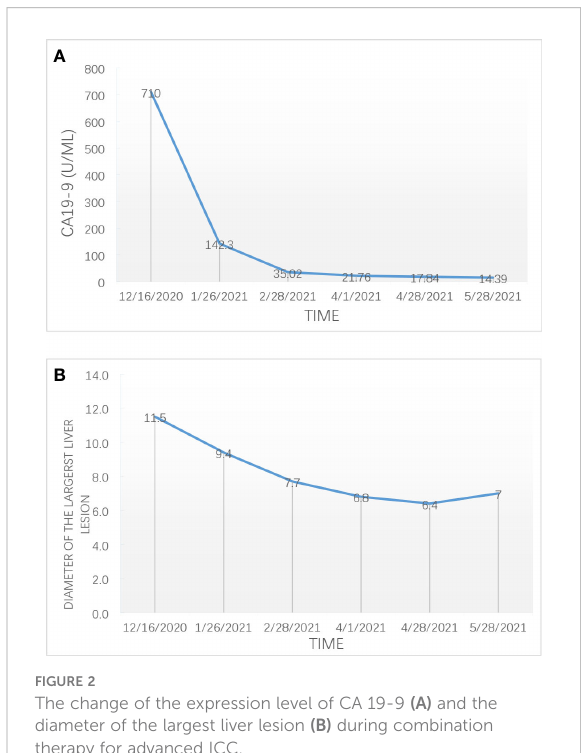
FIGURE 2 The change of the expression level of CA 19-9 (A) and the diameter of the largest liver lesion (B) during combination therapy for advanced ICC.